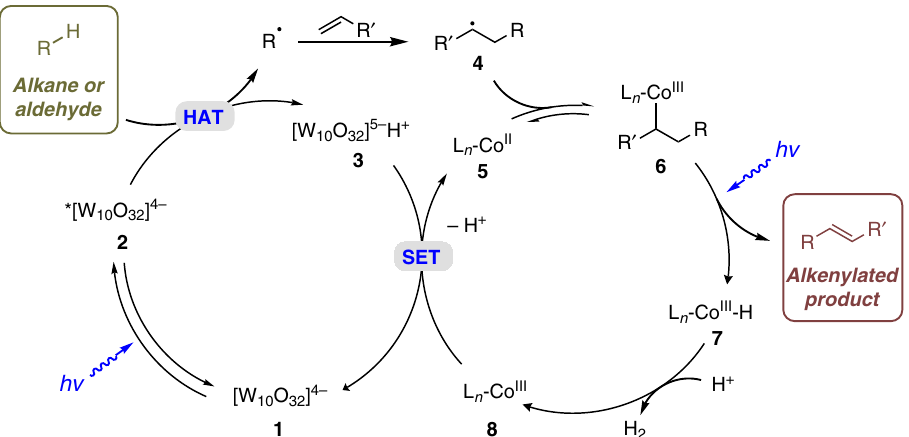
Fig. 2 Proposed mechanism for the dehydrogenative alkenylation of alkanes and aldehydes. The plausible mechanism involves a hydrogen atom transfer process, a single electron transfer process, and cobalt-catalyzed alkene formation and